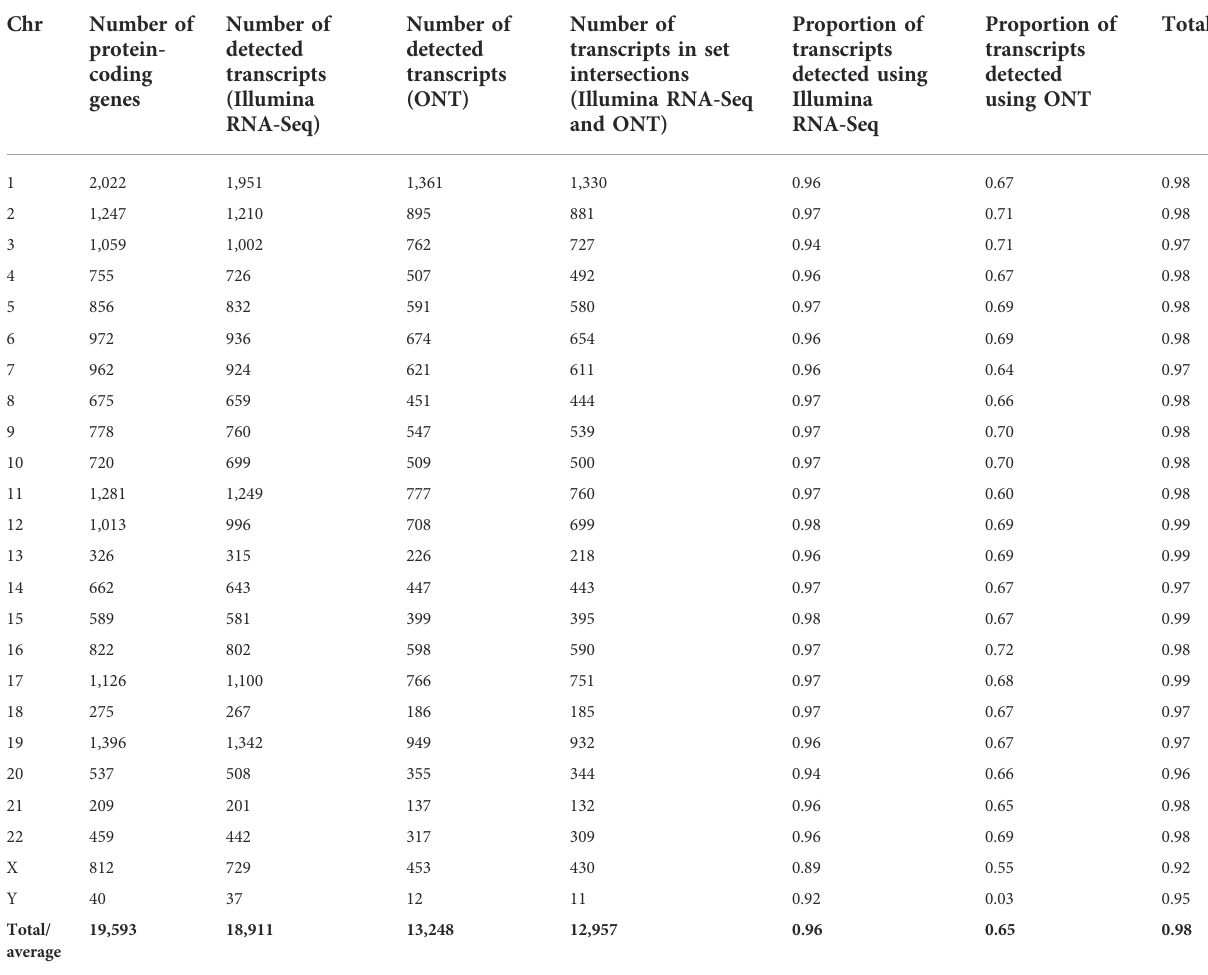
TABLE1DistributionoftranscriptsdetectedinthelivertissuesamplesbytheIlluminaRNA-Seq(FPKM > 0)andONT(TPM > 0)methodsacrosshuman